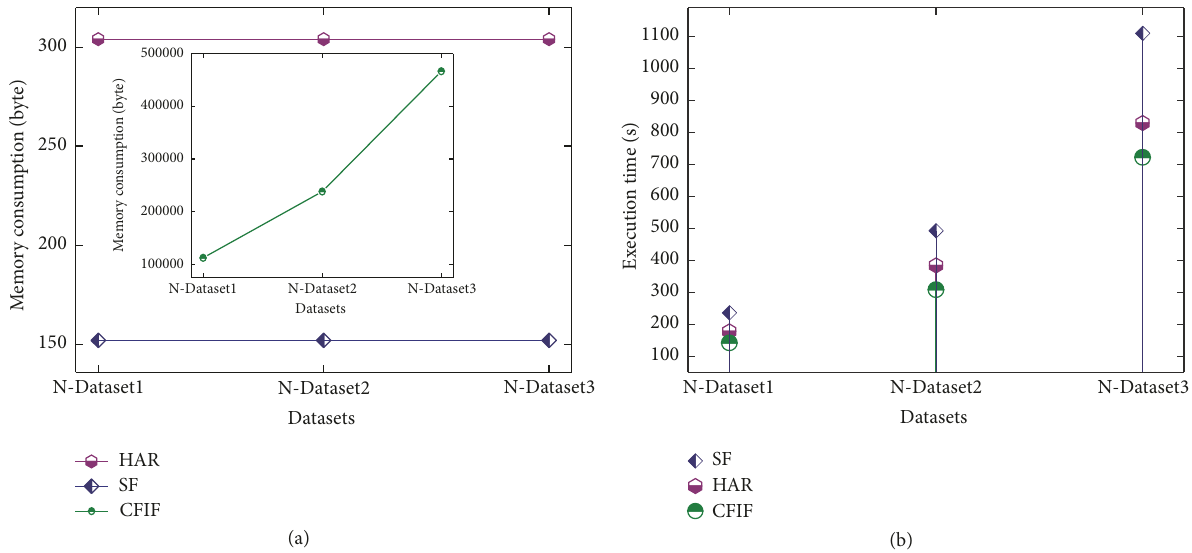
Figure 8: Memory consumption of Namenode and execution time of MapReduce for HAR, SF, and CFIF. (a) Memory consumption of Namenode and (b) execution time of